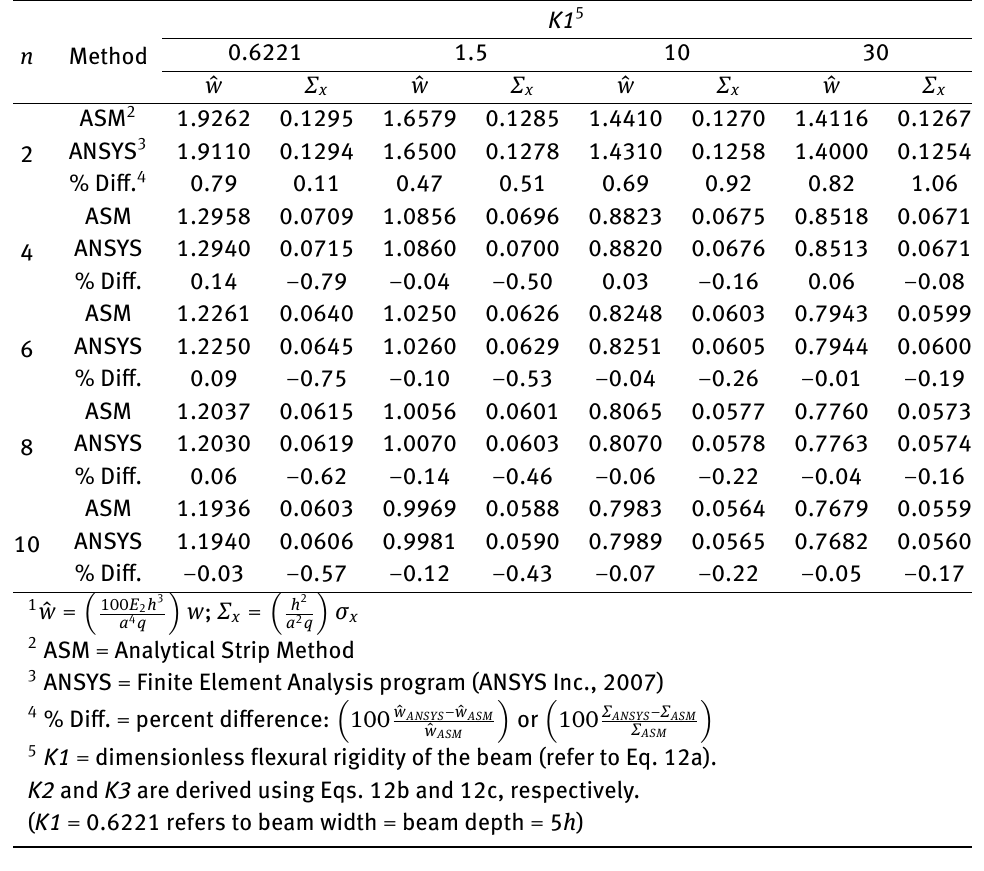
Table 5: Effect of beam stiffness ( K1 ) and number of layers ( n ) on the deflection ^ w 1 and stresses Σ 1 x at the center of uniformly loaded anti- symmetric cross-ply square laminates having three edges simply supported and the fourth edge ( x = a ) beam supported ( a / h =